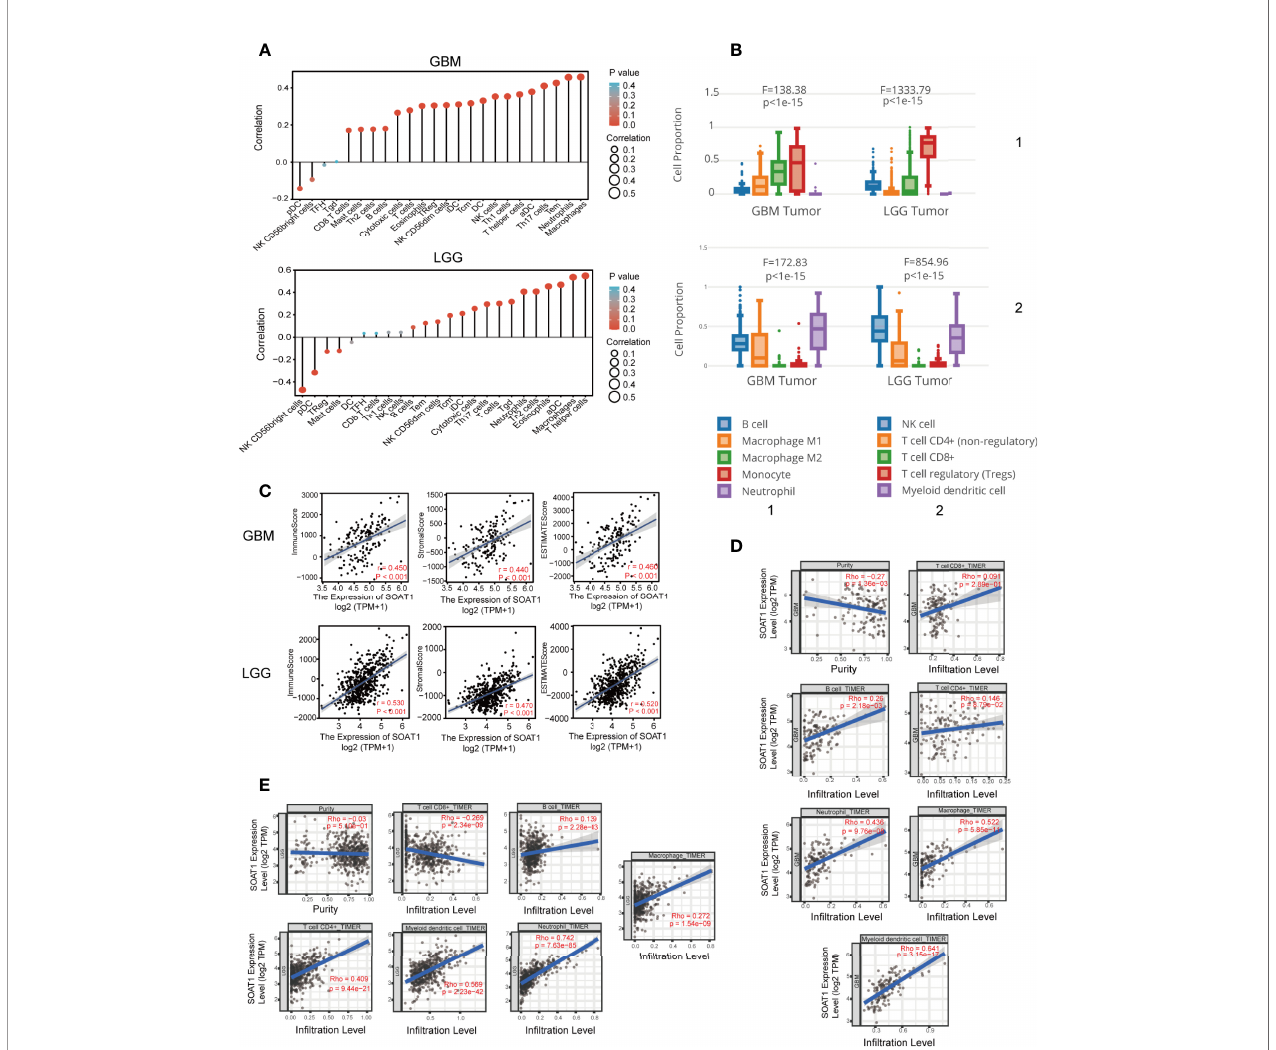
FIGURE 3 | SOAT1 expression was associated with immune in fi ltration in the tumor microenvironment. (A) Correlation analysis of SOAT1 expression with immune in fi ltrating cells in GBM and LGG by ssGSEA algorithm based on the TCGA cohort. (B) Relationship between the proportion of immune cell in fi ltration and the expression level of SOAT1 from GEPIA2021. (C) Correlation analysis of SOAT1 expression with immune, stromal, and ESTIMATE scores in GBM and LGG. (D) Correlation analysis of SOAT1 expression with purity of tumor, macrophage, neutrophil, myeloid dendritic cell, CD8+ T cell, CD4+ T cell, and B cell in GBM from TIMER2.0. (E) Correlation analysis of SOAT1 expression with purity of tumor, macrophage, neutrophil, myeloid dendritic cell, CD8+ T cell, CD4+ T cell, and B cell in LGG from TIMER2.0. aDC, activated DC; DC, dendritic cells; iDC, immature DC; NK, natural killer; pDC, plasmacytoid DC; Th cells, T helper cells; Tcm, T central memory; Tem, T effector memory; TFH, T follicular helper; Tgd, T gamma delta; Th cells, T helper cells; Treg, T regulatory cells. SOAT1 , sterol O-acyltransferase 1 ; GBM, glioblastoma; LGG, lower grade glioma; ssGSEA, single-sample GSEA; TCGA, The Cancer Genome Atlas; GEPIA, gene expression pro fi ling interactive